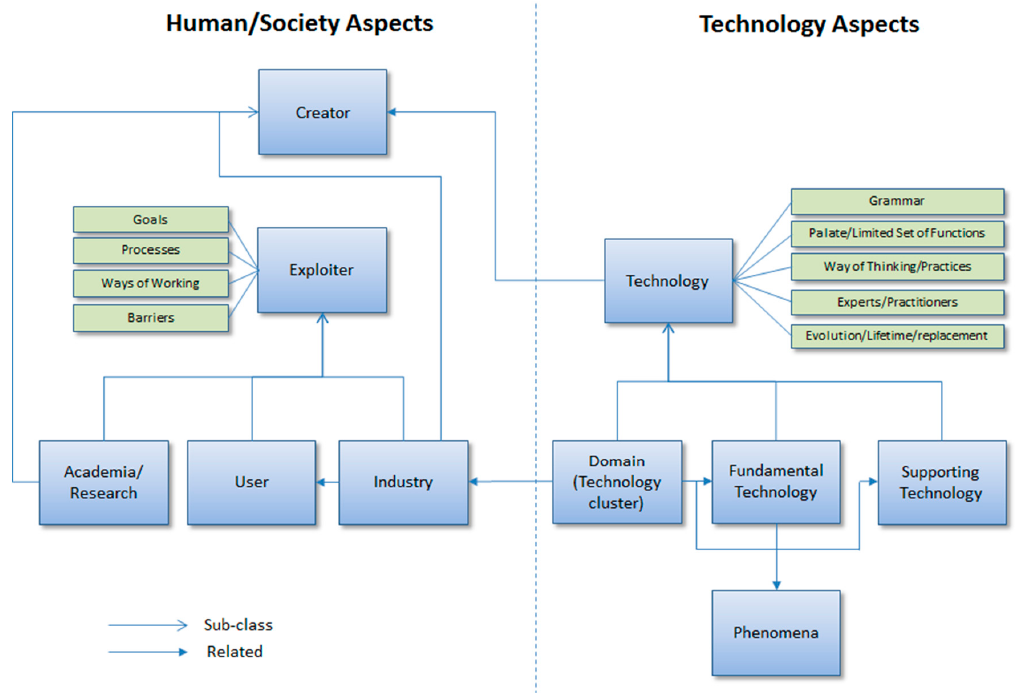
Figure 6. Model of the nature of technology derived from Arthur (2009)[7]. ISPRS Int. J. Geo-Inf. 2018 , 7 , x FOR PEER REVIEW